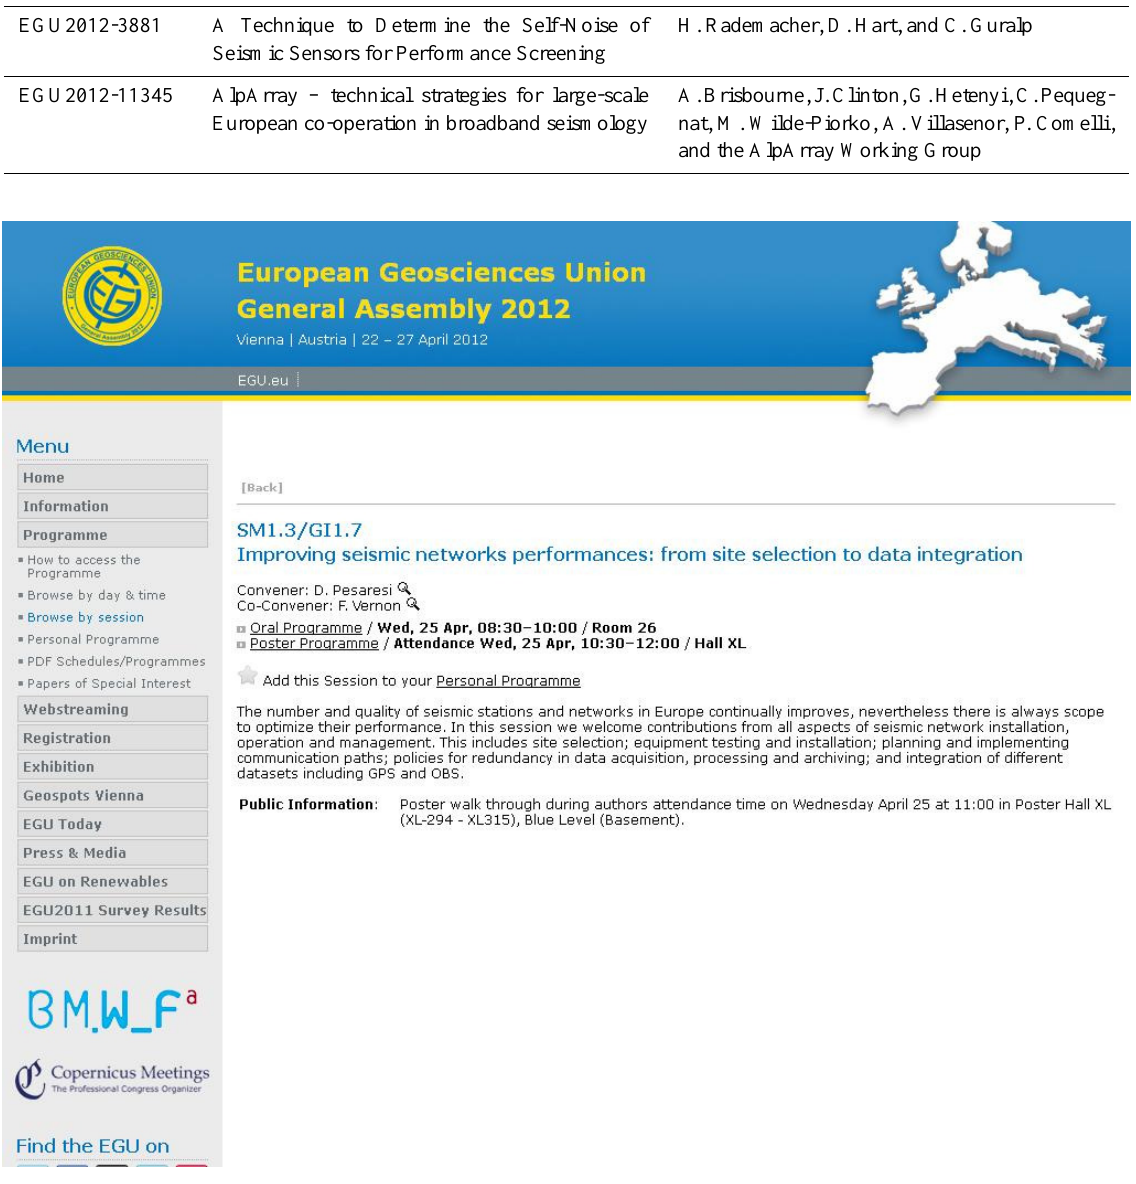
Fig. 1. EGU2012 SM1.3/GI1.7 session (from EGU2012 Figure 1. EGU2012 SM1.3/GI1.7 session (from EGU2012 Homepage). 3